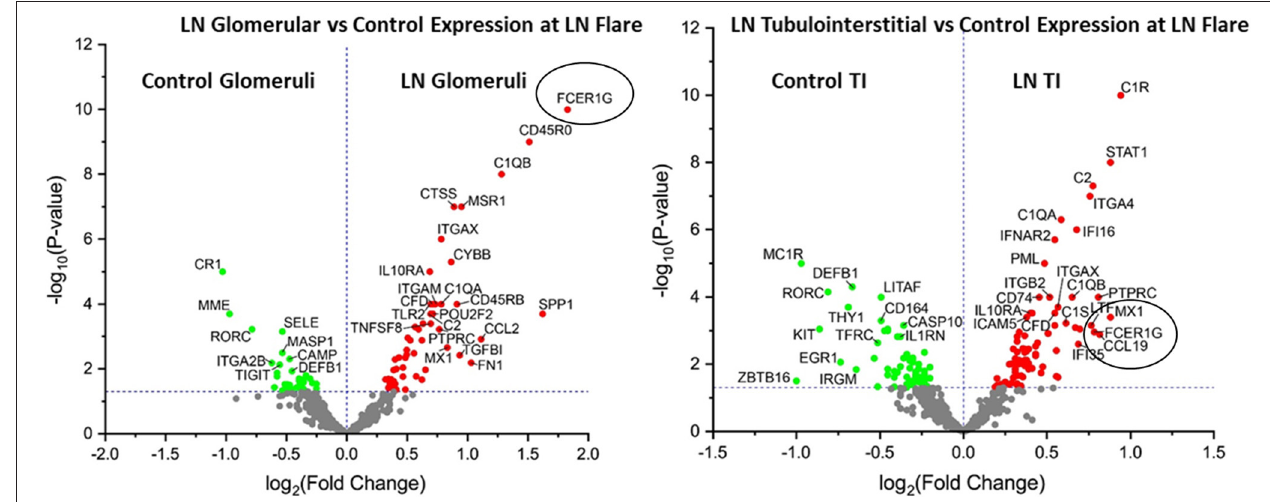
FIGURE 1 | FCER1G is one of the top differentially expressed transcript in patients with lupus nephritis (LN). Volcano plot showing expression of FCER1G and other top differentially expressed transcripts in human LN glomeruli (G) (left) and tubulointerstitium (right) at the LN flare compared to healthy controls (HCs).